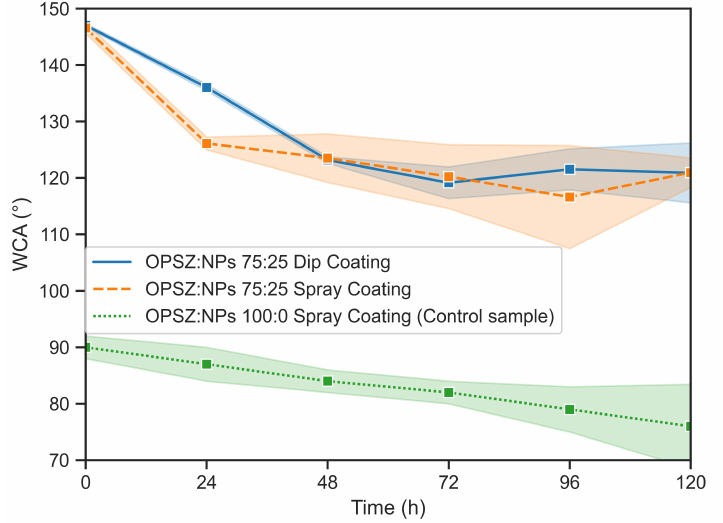
Figure 11. Contact angle measurements versus artificial weathering test time (shadowed area cor- responds to the standard deviation).